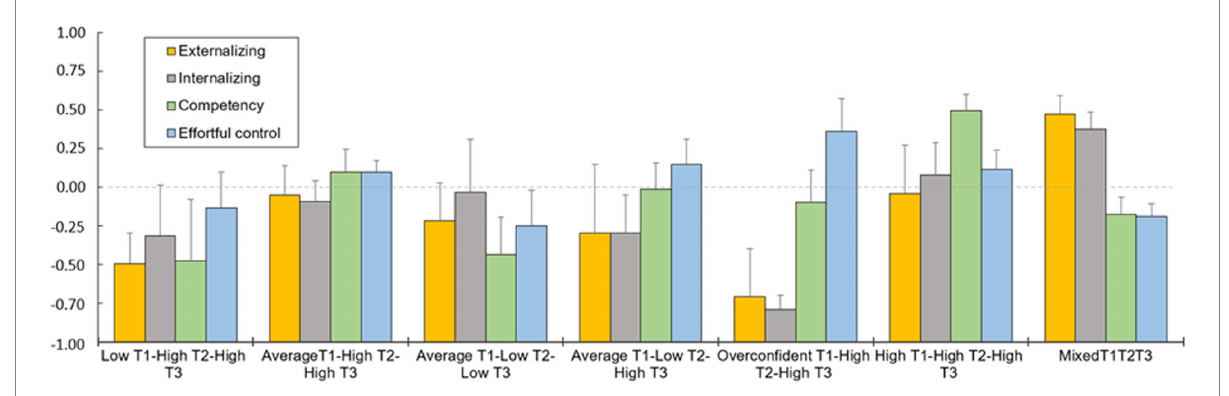
FIGURE 3 Associations between the maternal PRF trajectories and child outcomes. T1, pregnancy; T2, Child’s age of 6 months; T3, Child’s age of 2 years.